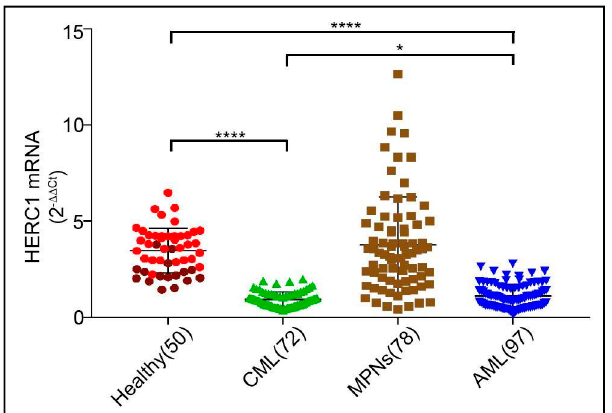
Figure 1. The HERC1 gene expression is differently regulated in bone marrow (BM) and peripheral blood (PB) and it is dysregulated in haematological malignancies. HERC1 transcript was assayed in healthy donors including both PB (red dots) and BM (dark red dots), and in a panel of myeloid related disorders at diagnosis, namely Chronic Myeloid Leukemia (CML) (PB = 37, BM = 35), Acute Myeloid Leukemia (AML) (PB = 17, BM = 80), MyeloProliferative Neoplasms (MPNs) (PB = 75) by RT-qPCR. The HERC1 mRNA quantity was expressed as 2 - ΔΔ Ct after normalization against GUSB . HERC1 gene expression was significantly downregulated in newly diagnosed CML and AML, with median values of 0.9 and 1 respectively, when compared to healthy specimens (median = 4.01). In MPNs the HERC1 expression fluctuated from 0.4 to 12.65 with a median value of 3.3 and thus not significantly different from healthy subjects. p -values were calculated on the differences in HERC1 gene expression observed between patients and the healthy control specimens. * p < 0.05, **** p < 0.0001. When compared to the pool of PB and BM healthy specimens, the HERC1 gene expres- sion was sharply downregulated at diagnosis both in acute (median value approximately of 1.0) and in chronic myeloid (median value approximately 0.93) leukemia.